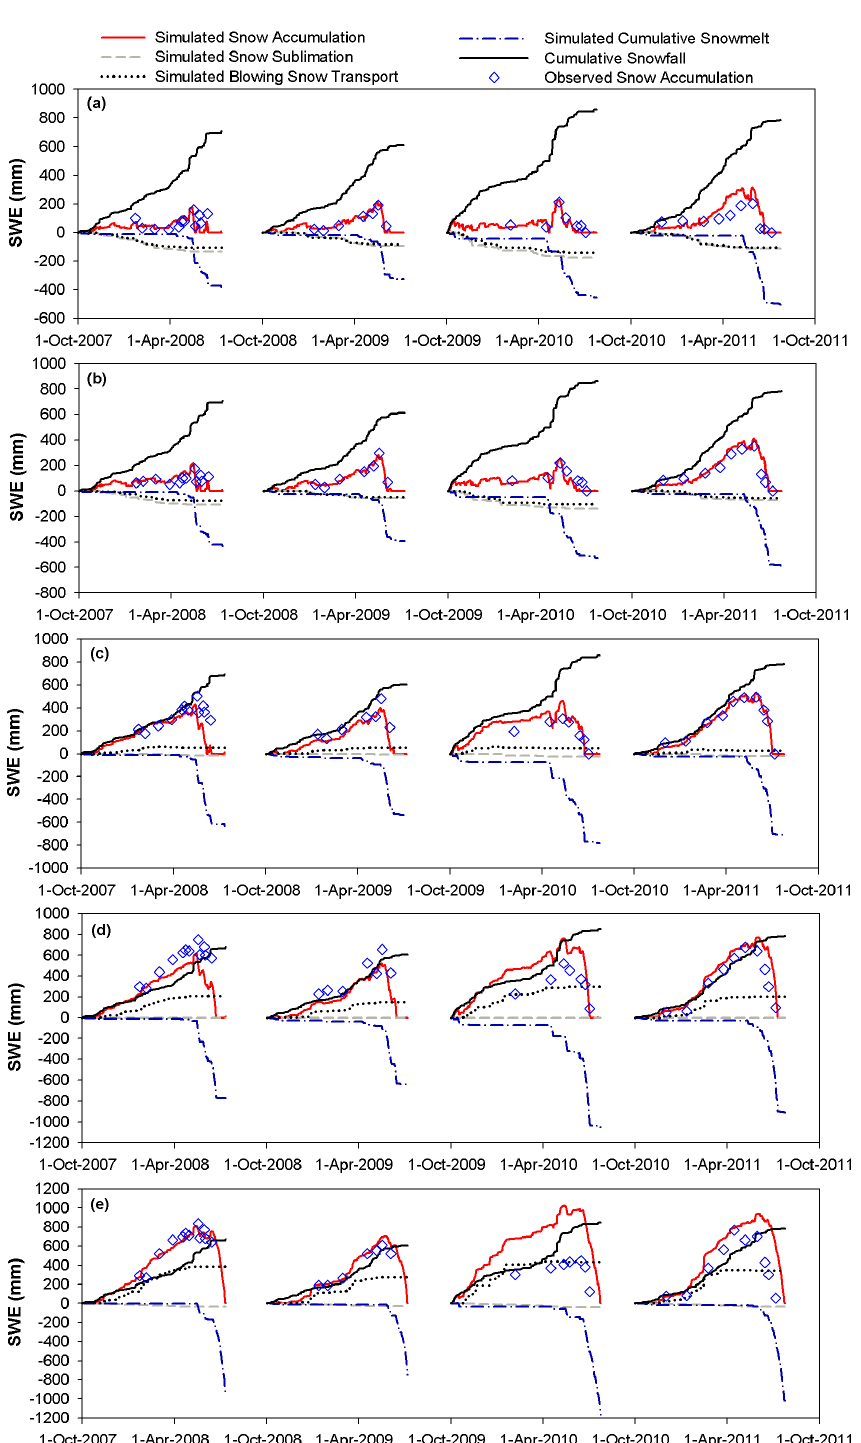
Fig. 7. Comparisons of the observed and simulated snow accumulation (SWE) for 2007–2011 at the wind-blown, high-elevation Fisera Ridge in the MCRB. (a) North-facing slope, (b) ridge top, (c) top south-facing slope, (d) bottom south-facing slope, and (e) larch